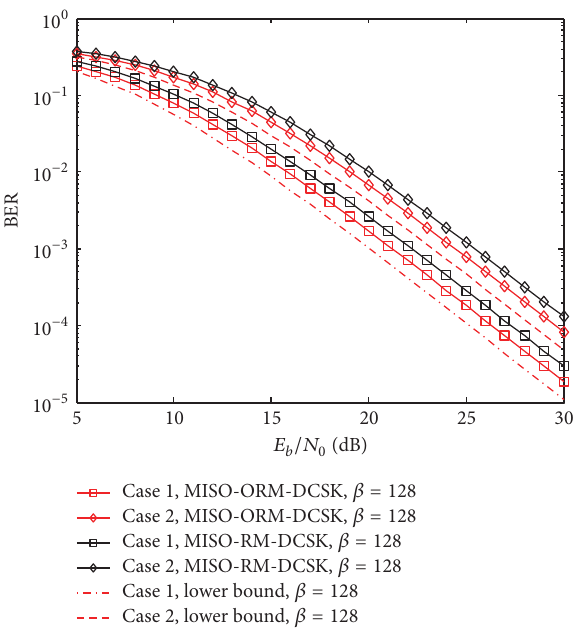
Figure 9: BER performance in Rayleigh fading channel with different gains.